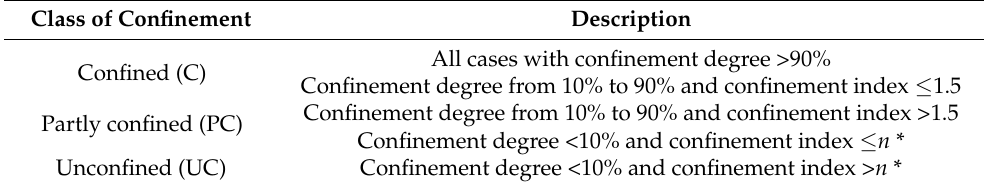
Table 2. Classes of